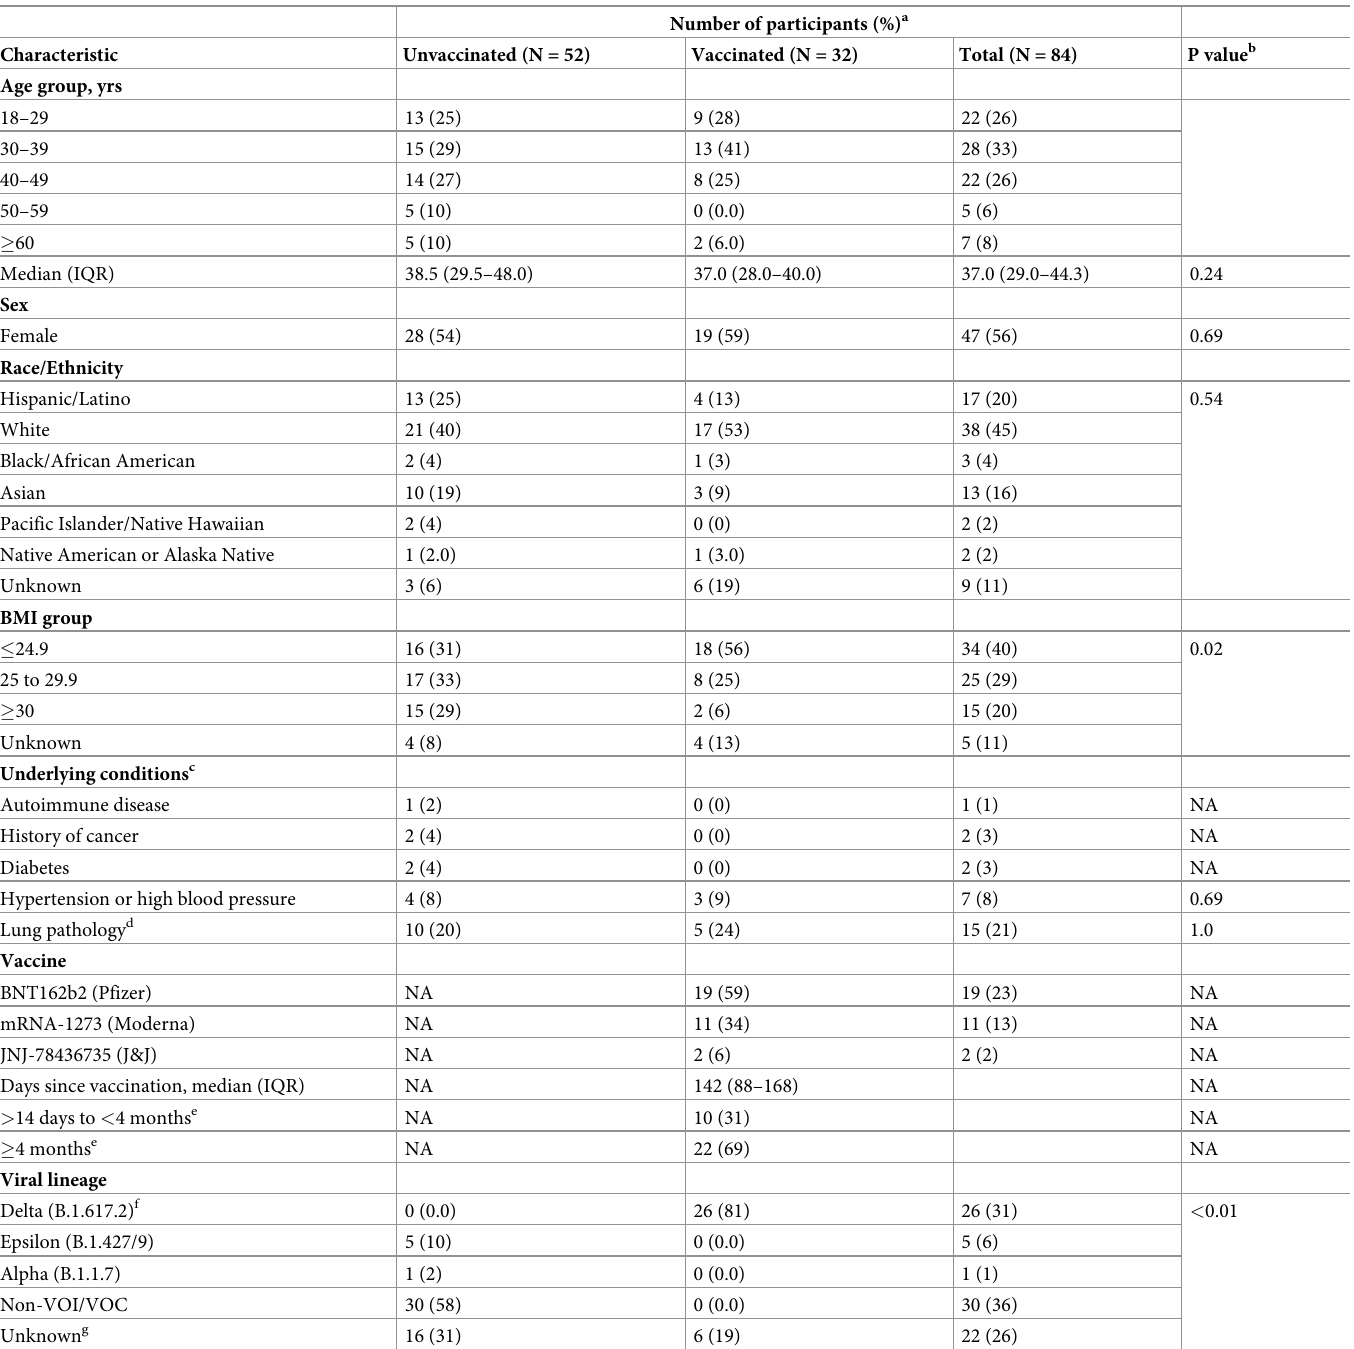
Table 1. Participant demographics, vaccination status and viral